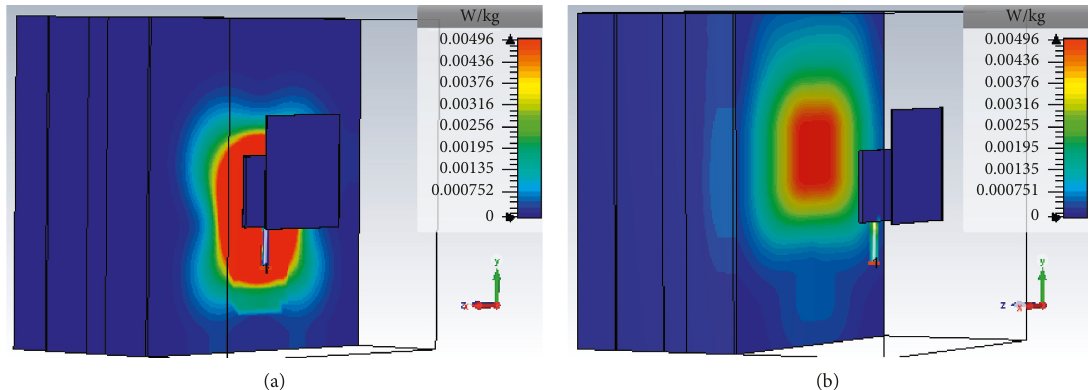
Figure 16: 3D SAR of the proposed reflector-backed antenna with separation distance of (a) 4mm and (b) 30mm from the multilayer